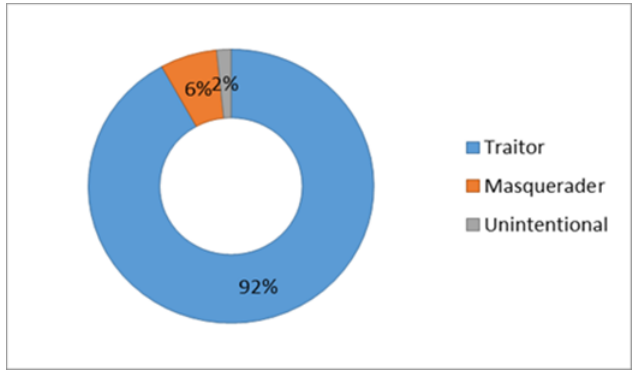
Figure 4. Types of insiders.